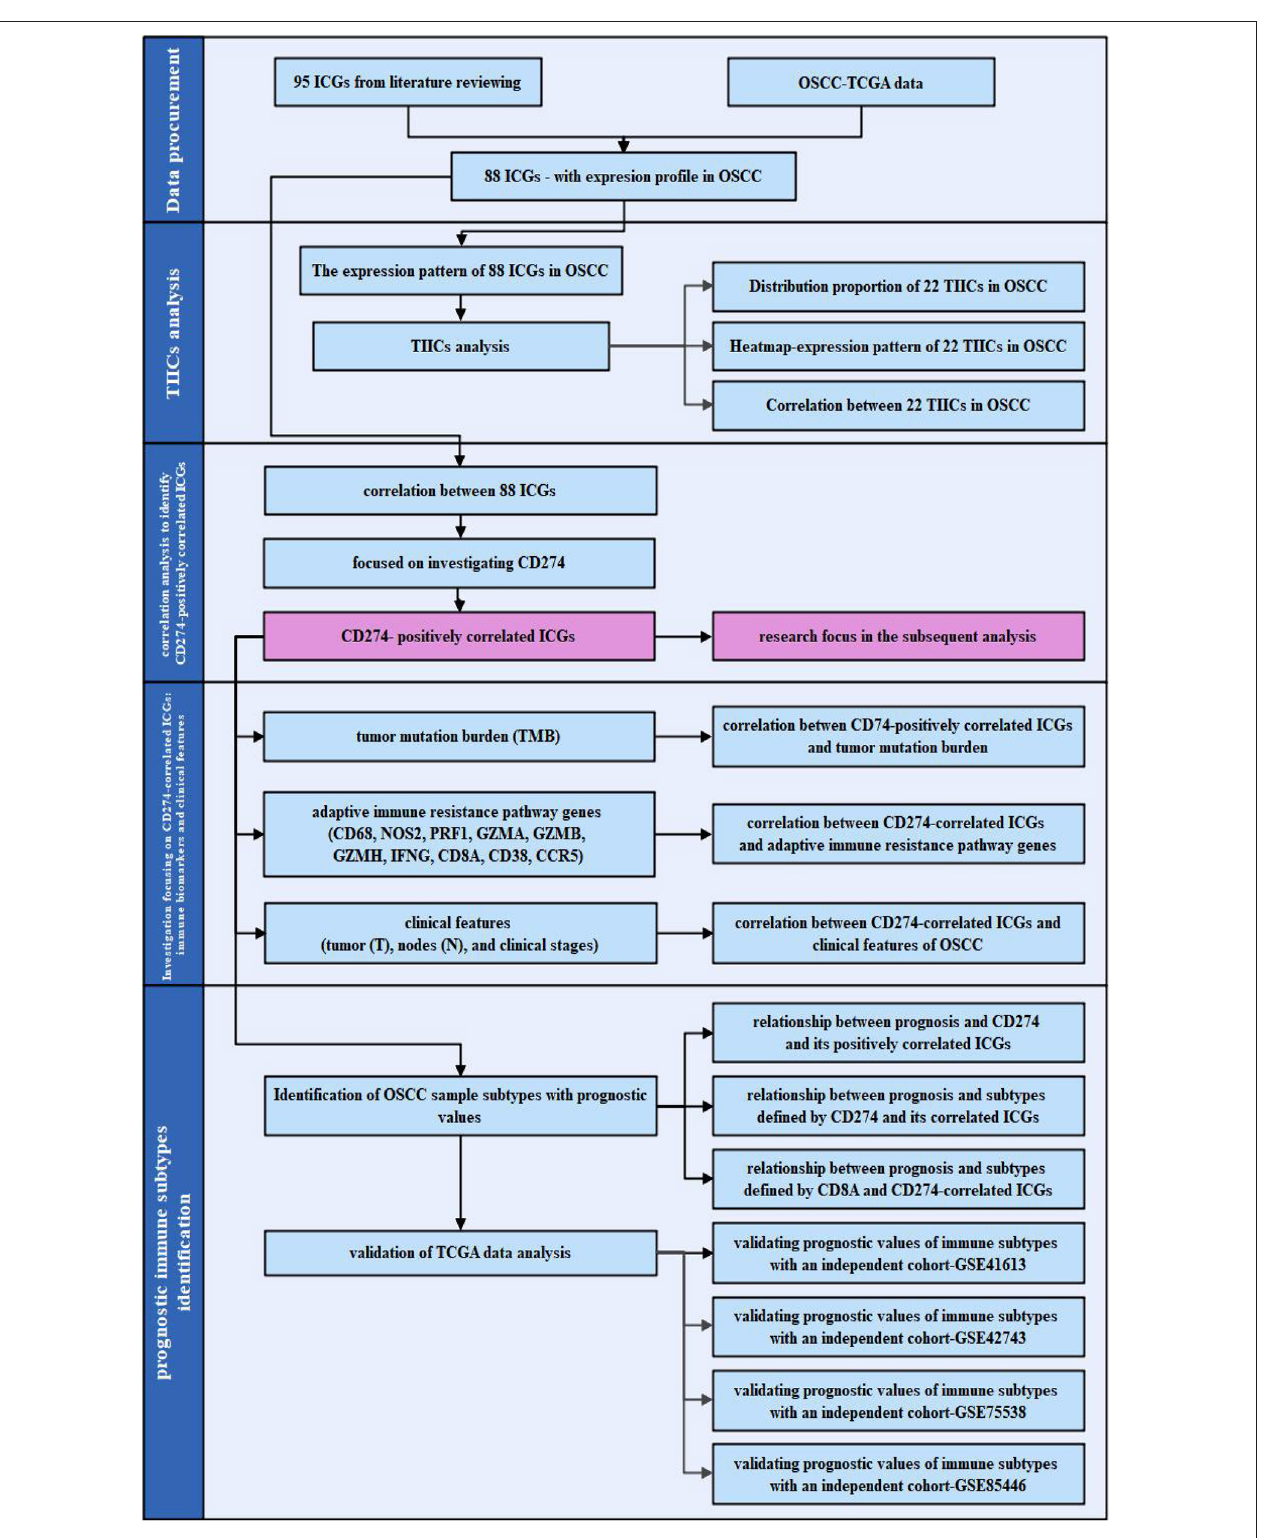
FIGURE 1 | The work flowchart of the present study. The flowchart is divided into four steps: data procurement for obtaining the 88 immune checkpoint genes (ICGs) with the expression profile in the Cancer Genome Atlas (TCGA) oral and squamous cell carcinoma (OSCC) data set; tumor-infiltrating immune cells (TIICs) analysis; a correlation analysis for identifying ICGs positively correlated with CD274; and subsequent analysis focusing on the ICGs positively correlated with CD274 particularly